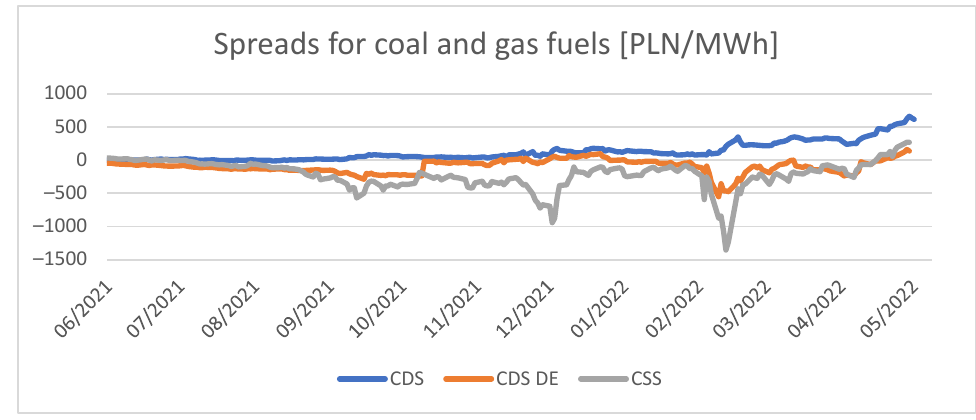
Spreads for coal and gas fuels [PLN/MWh] –1500–1000–50005001000